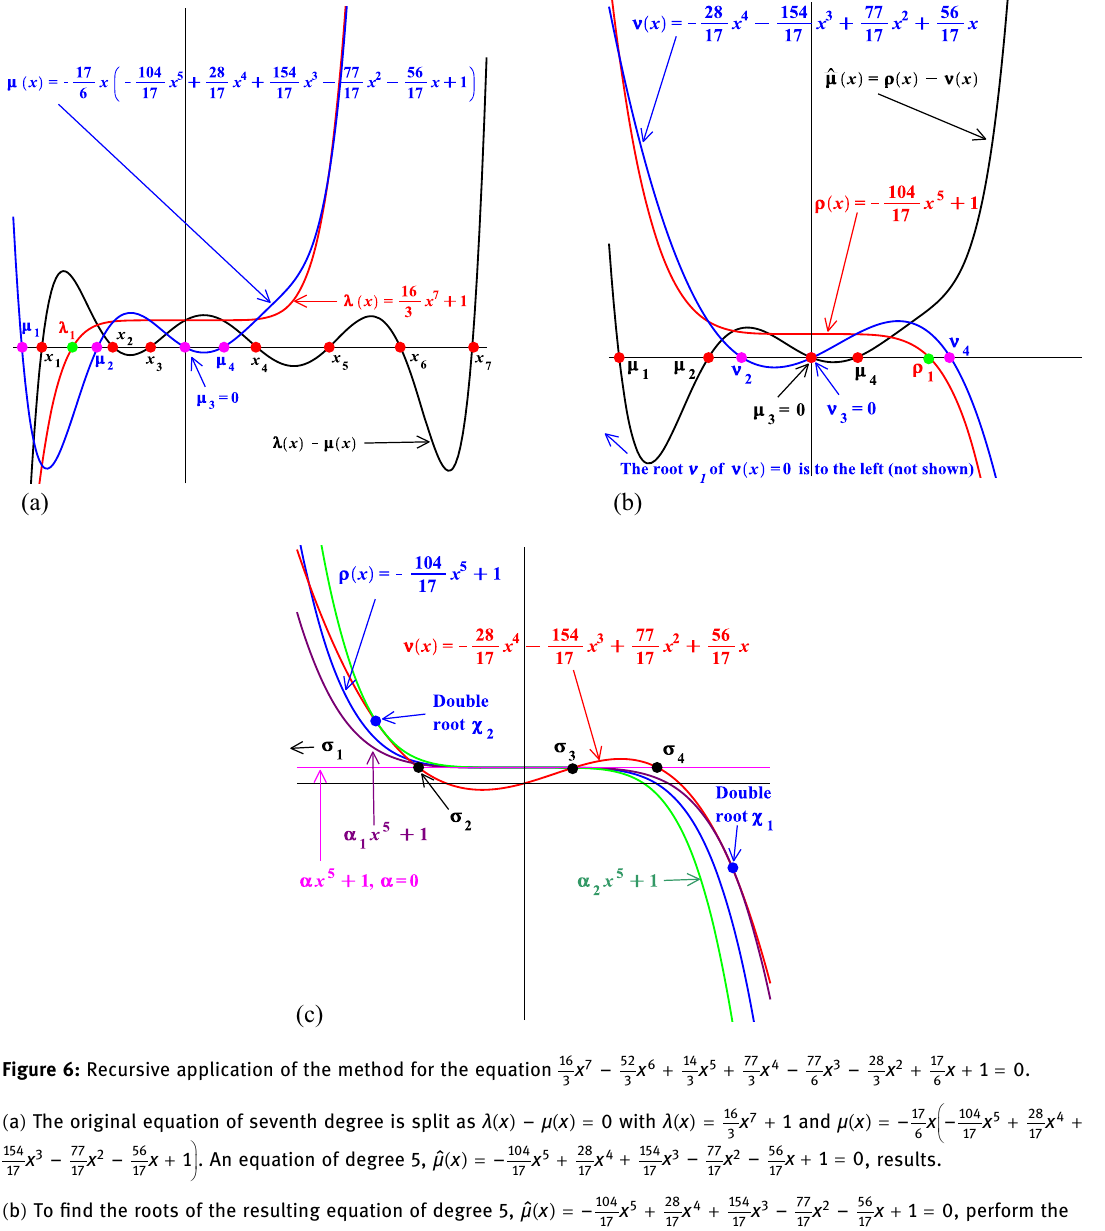
Figure 6: Recursive application of the method for the equation